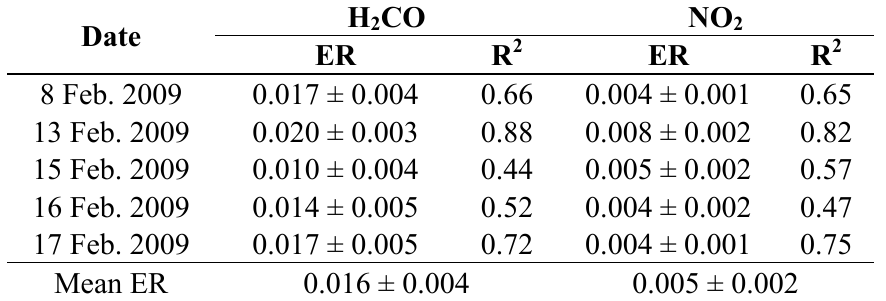
Table 1. Emission ratios of H Victorian fires including correlation coefficients from each linear regression analysis a